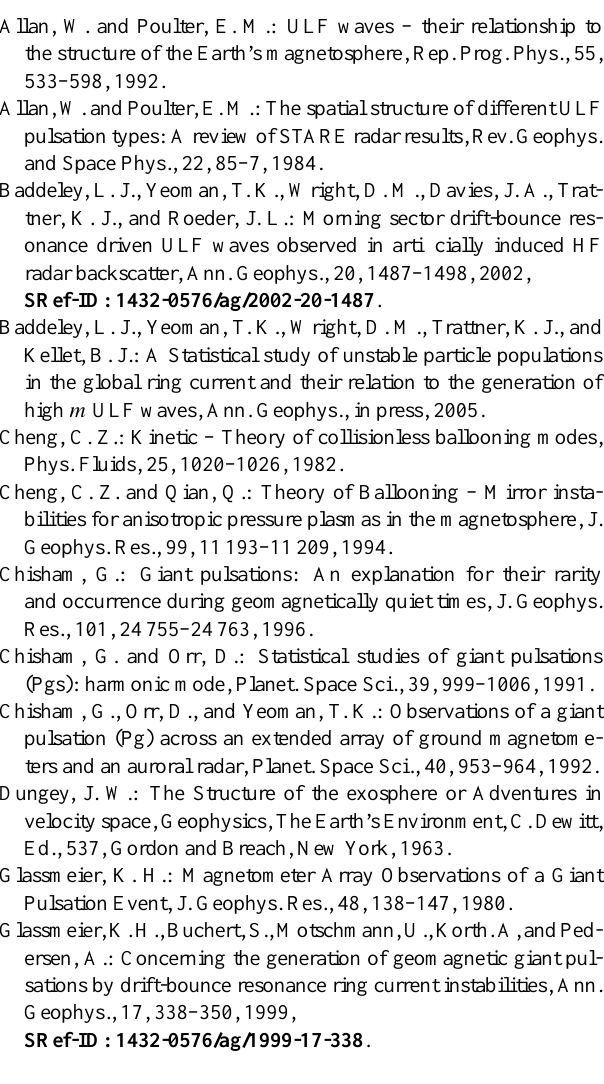
Figure 9. Fig. 9. (Modified from Fig. 5 taken from Baddeley et al., 2005). Results from a statistical study of magnetospheric particle popula- tions, using the TIMAS and CAMMICE (MICS) instruments. Al- most three years of data were binned according to MLT location and also according to the free energy each IDF contained in the form of a positive gradient region. The radial distance from the centre of the semi-circle indicates increasing amounts of free energy available up to a maximum of 1.8 × 10 11 J in bin increments of 1.2 × 10 10 J. The data bins are colour coded as a percentage occurrence in that MLT